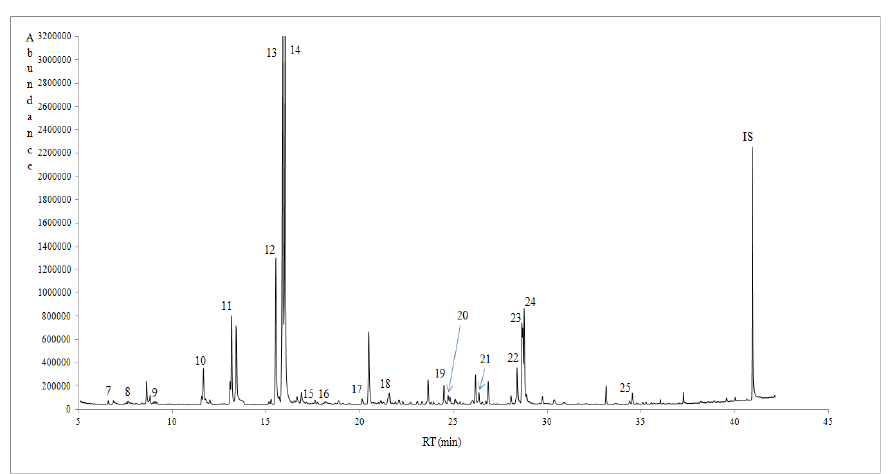
Figure 1. ( a ) A typical gas chromatogram of prickly pear juice sample (no. 12) from Western Messinia. 1: dl-Limonene. IS: internal standard. ( b ) A typical gas chromatogram of prickly pear juice sample (no. 3) from Eastern Messinia. 2: Hexanol. 3: 3,5-Hexadien-1-ol. 4: Decene. 5: Decane. 6: Dodecene. IS: Internal standard. ( c ) A typical gas chromatogram of prickly pear juice sample (no. 11) from Lakonia. 7: 2,4-